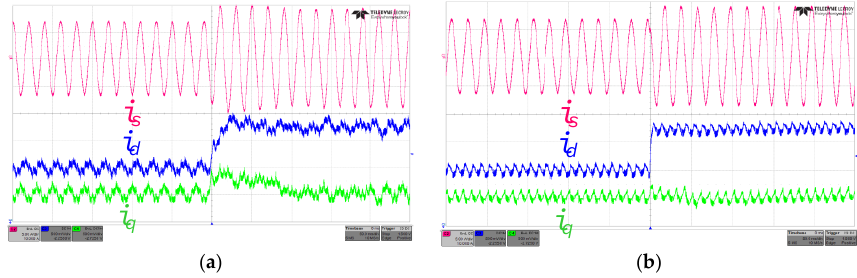
Figure 13. Experimental results for the inductance current i s , the d-axis current i d , the q-axis current i q when 𝐿̂ = 1.4 L . ( a ) ICSF-based PI control; and ( b ) the proposed complex vector based control.